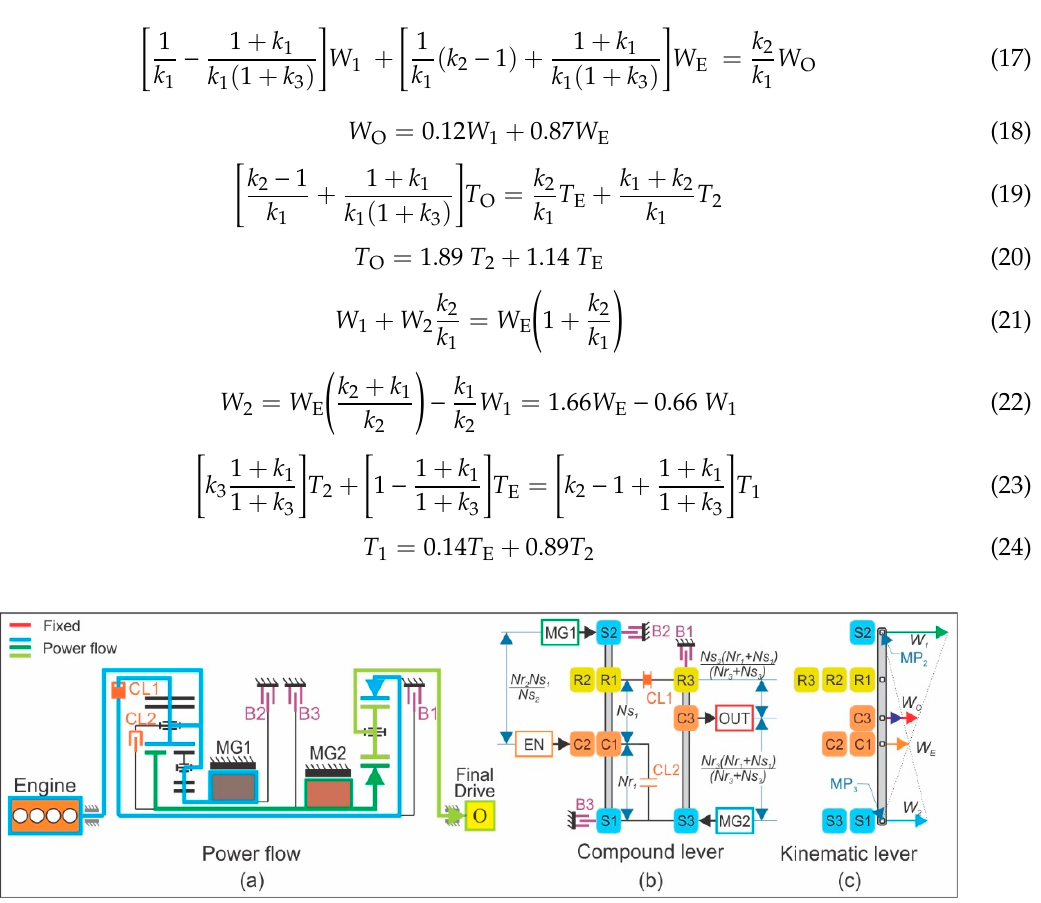
(26) Figure 20. First fixed gear. 10.4.2. 2nd Fixed Gear With (cid:1849) (cid:2929)(cid:2869) = (cid:1849) (cid:2929)(cid:2871) = (cid:1849) (cid:2870) , (cid:1849) (cid:2929)(cid:2870) = (cid:1849) (cid:2869) = 0, (cid:1849) (cid:2928)(cid:2871) = 0